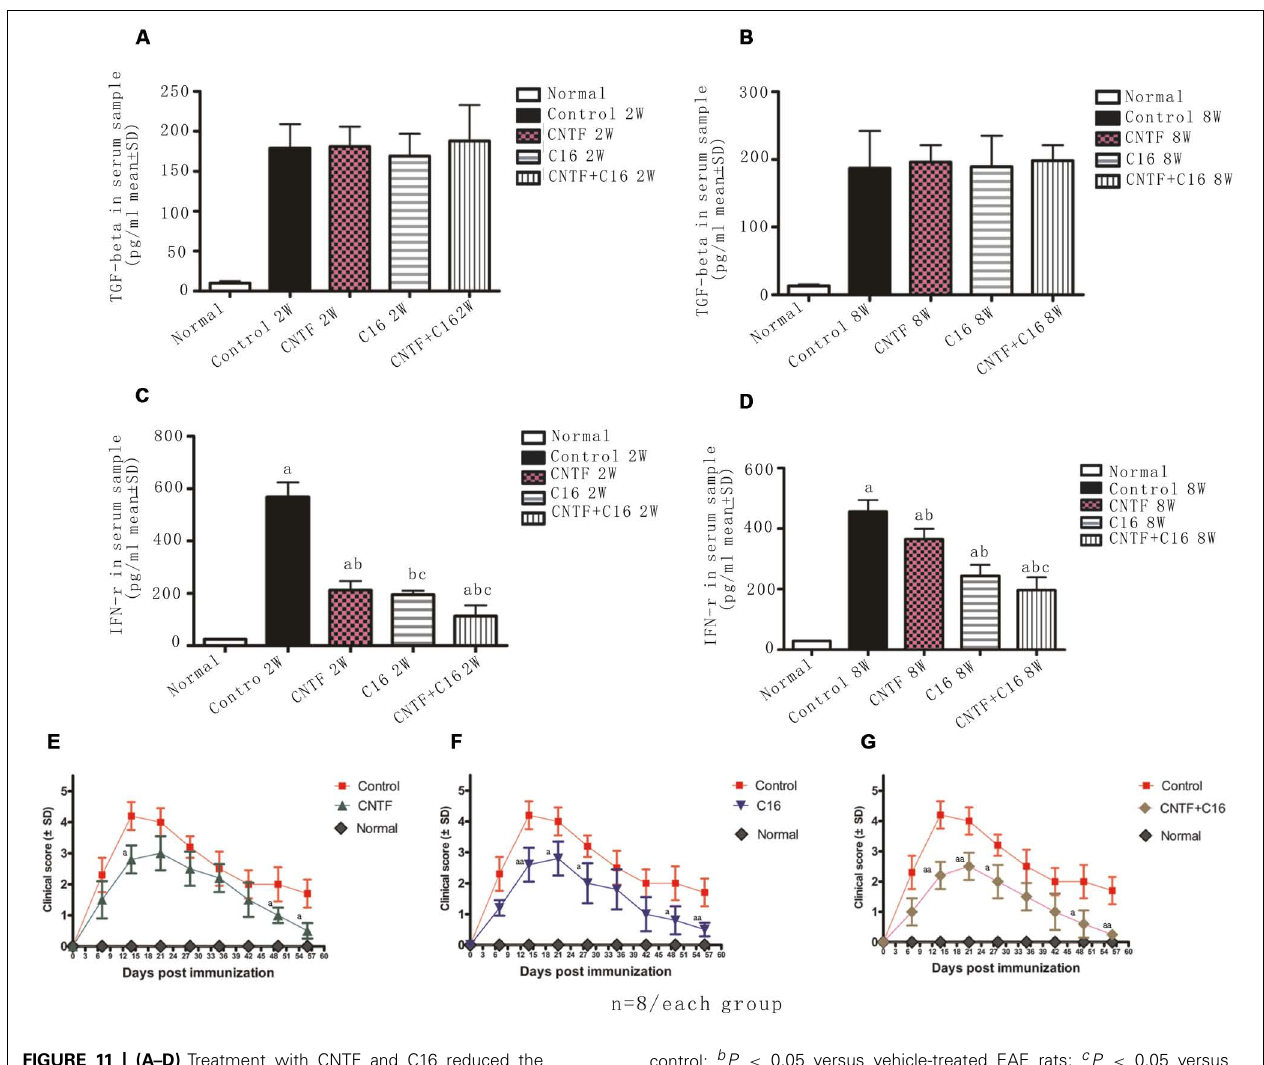
control; b P < 0.05 versus vehicle-treated EAE rats; c P < 0.05 versus CNTF-treated EAE rats. (E–G) Treatment with CNTF or C16 halted disease progression and reduced disease severity. The clinical progression of EAE was attenuated after CNTF (E) , C16 (F) , and C16 + CNTF (G) treatments. a P < 0.05 versus the vehicle-treated group at the same time point. aa P < 0.01 versus the vehicle-treated group at the same time